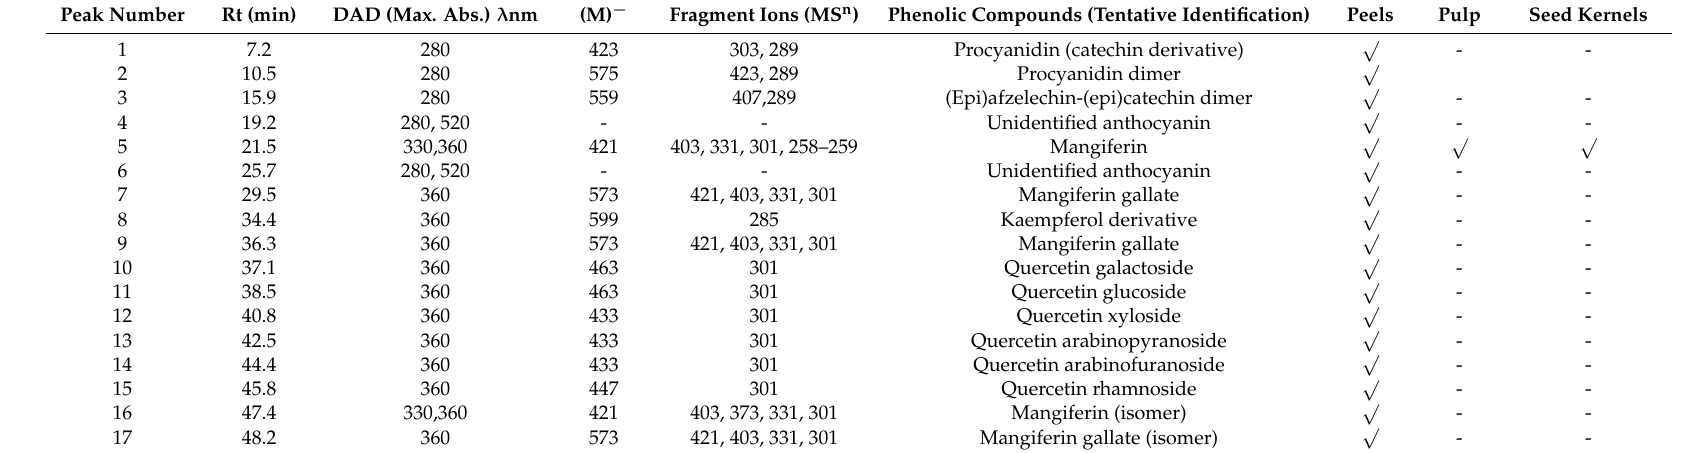
Table 3. Tentative identification of phenolic compounds in mango organs (peels, pulps and seed kernels) by HPLC–DAD–ESI-MS n